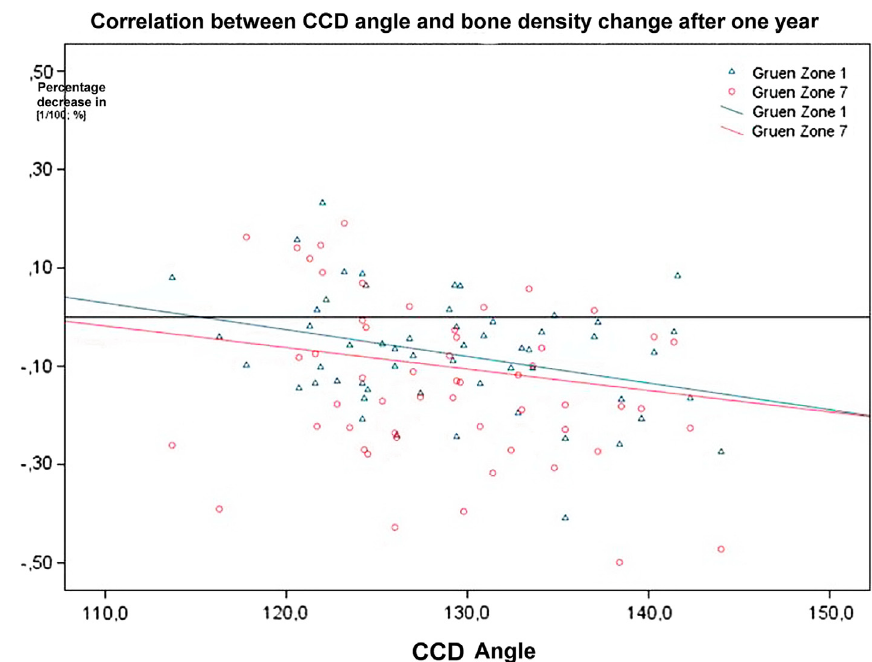
Figure 7. Correlation between CCD angle and bone density change after one year. Table 5. Analysis of covariance. Variable Dataset with missing Pooled values